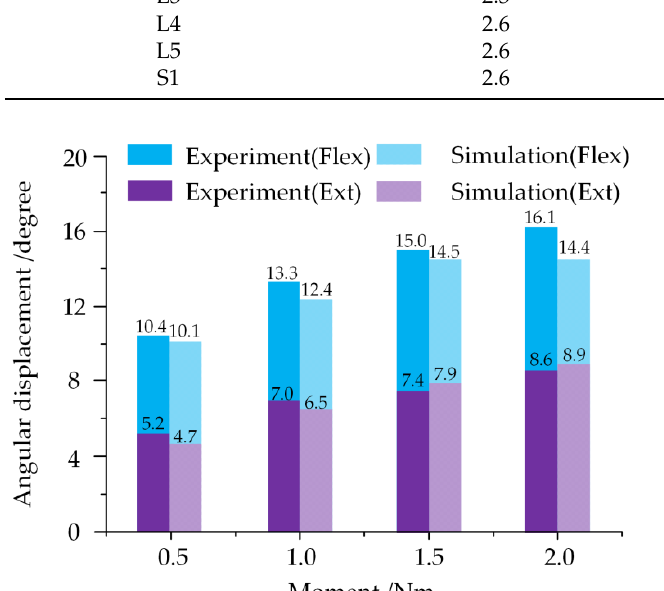
Figure 5. Comparison of angular displacement between experimental results and simulated results [27]. results